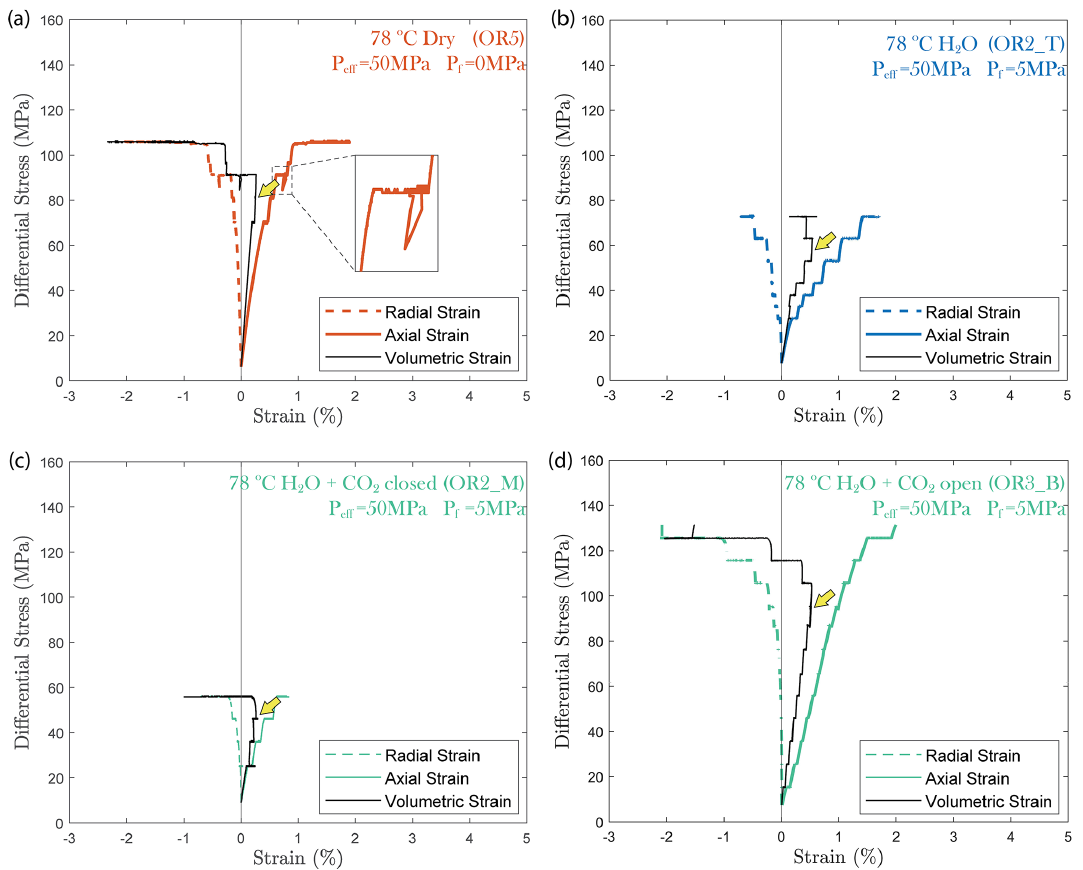
Figure 5. Plots of volumetric strain for (a) dry, (b) H 2 O, (c) H 2 O + CO 2 closed and (d) H 2 O + CO 2 open experiments. The onset of transition from compaction to dilatancy ( C ∗(cid:48) ) is marked by the yellow arrowhead. In the dry experiment, the differential stress exhibits temporary fluctuation at ∼ 90MPa (highlighted by the dashed